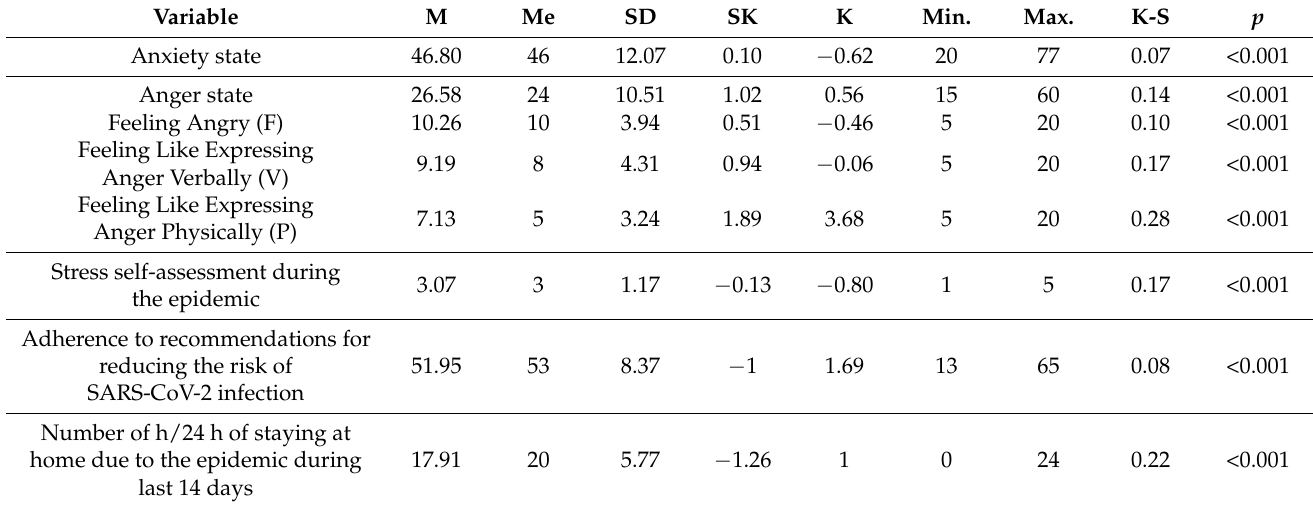
Table 3. Descriptive statistics of quantitative variables in stage II (n =